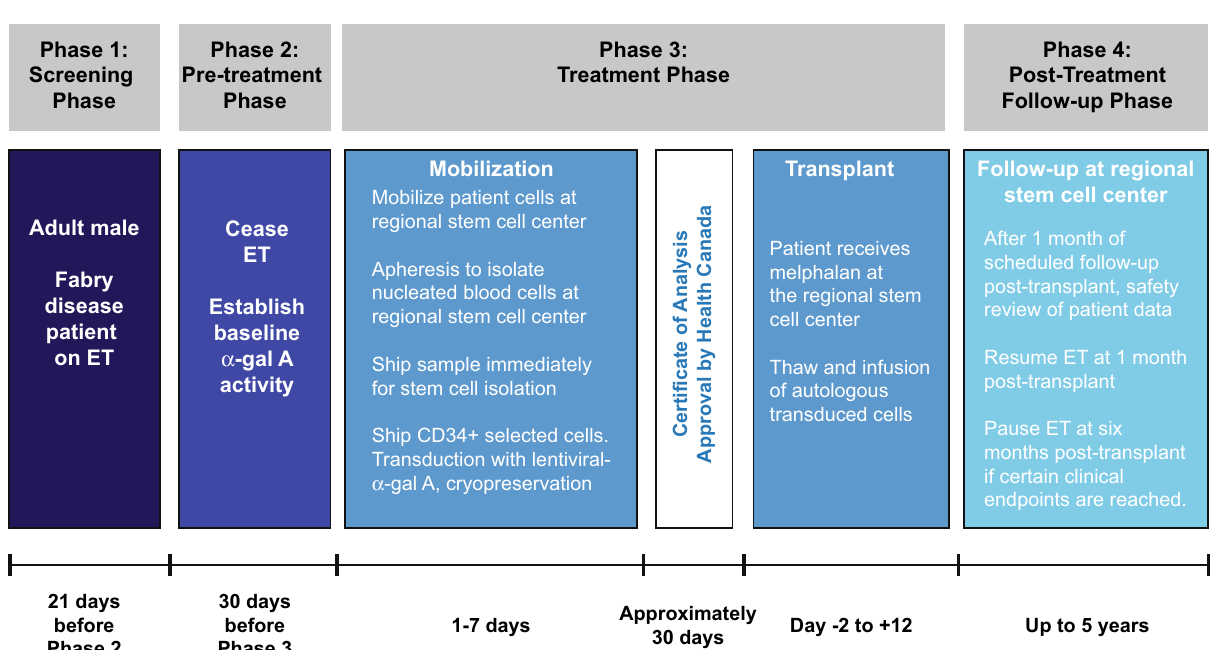
Fig. 1 Study schema. Five men with Type I Fabry disease were infused with autologous transduced CD34 + -selected hematopoietic stem/progenitor cells engineered to express α -galactosidase A ( α -gal A) following mild ablation. ET enzyme